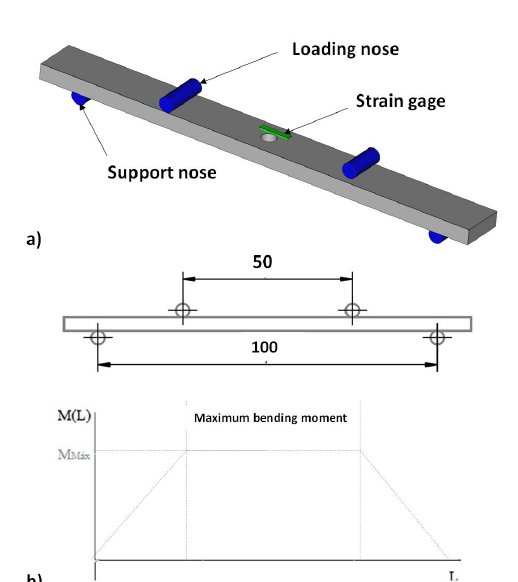
Figure 1. Test apparatus for four-point-bending: a) position of the hole; b) Bending moment diagram.